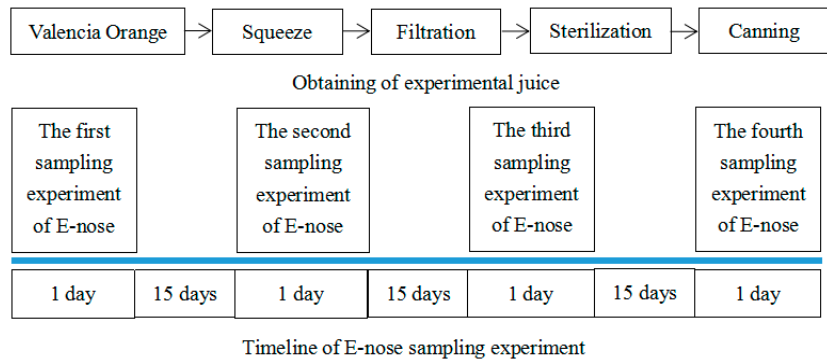
Figure 1. The obtainment of experimental juice and the timeline of an E-nose sampling experiment. Table 1. The analysis of orange juice aroma components.